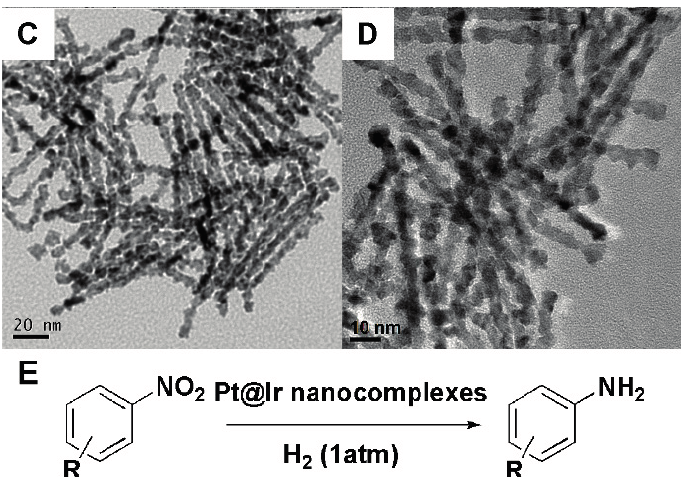
Figure 3. ( A ) The TEM and ( B ) high resolution TEM images of FePt nanorods; ( C )